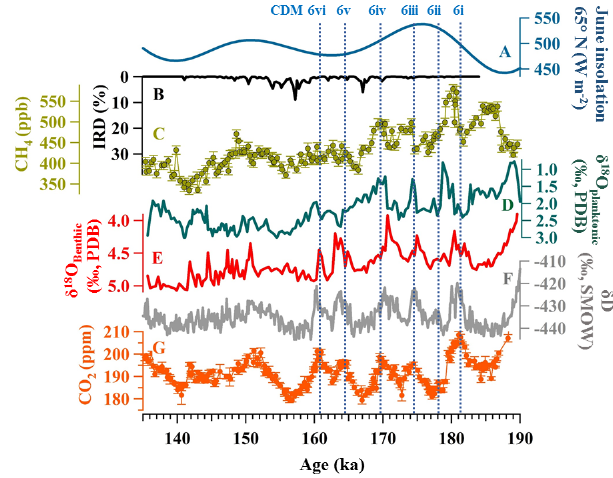
Figure 6. Comparison of climate proxies with atmospheric CO 2 during MIS 6 period. Vertical dotted blue lines indicate the six CDM events during the early MIS 6: (a) 21 June insolation at 65 ◦ N (Berger, 1978), (b) ice-rafted debris (IRD) input in the Iberian Mar- gin core MD95-2040 (de Abreu et al., 2003), (c) atmospheric CH 4 in the EDC ice core (Loulergue et al., 2008; this study), (d) δ 18 O of planktonic foraminifera in the Iberian Margin marine core MD01- 2444 (Margari et al., 2010), (e) δ 18 O of benthic foraminifera in the Iberian Margin marine core MD01-2444 (Margari et al., 2010), (f) δ D of the EDC ice core (Jouzel et al., 2007) and (g) our new com- posite CO 2 record during the MIS 6 period. The numbers of CDM events are indicated at the